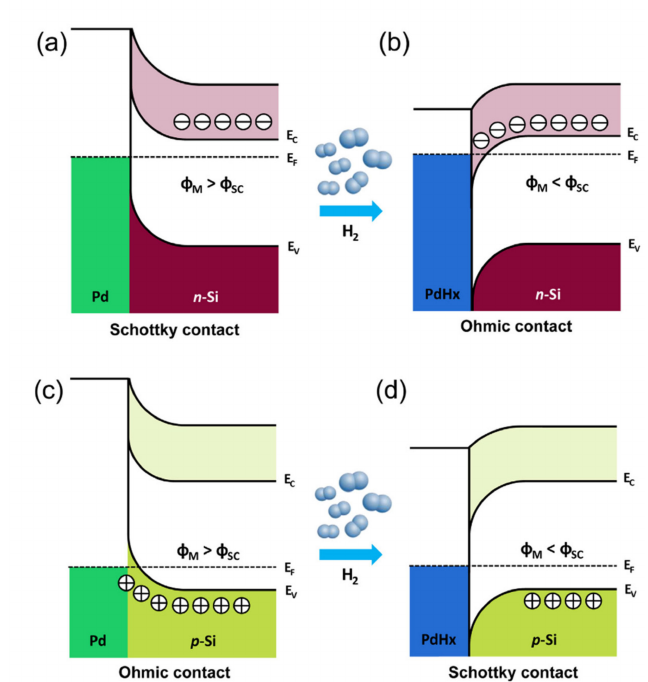
Figure 12. Schematic illustration of the change in contact resistance at the metal (Pd)-semiconductor (Si) junction: ( a ) formation of Schottky barrier in an n-type SiNW before the exposure of H 2 , ( b ) formation of Ohmic contact in the n-type SiNW after the exposure of H 2 , ( c ) formation of Ohmic contact in the p-type SiNW before the exposure of H 2 , and ( d ) formation of Schottky barrier in the p-type SiNW after the exposure of H 2. Reproduced from [139], with permission from Elsevier,